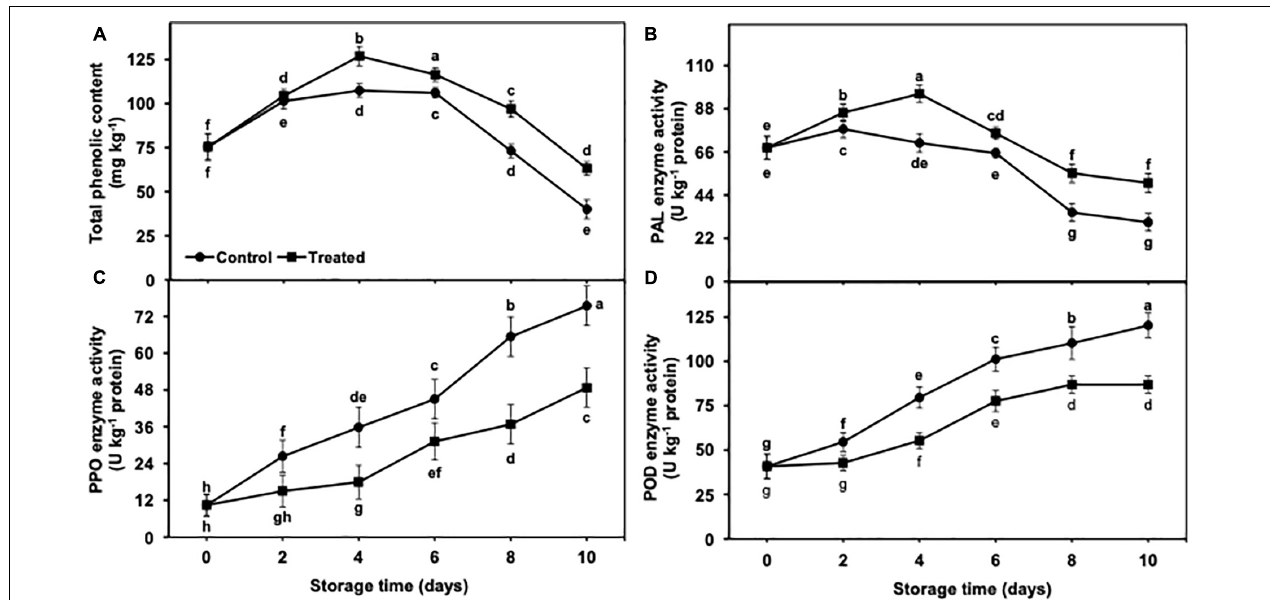
FIGURE 8 | Effect of hydrogen sulfide on total phenolic content (A) , PAL (B) , PPO (C) and POD (D) enzymes activity in peel of banana fruit. Data are mean of three replications and vertical bars show standard of the means. Different letters show significant difference according to least significant difference test.